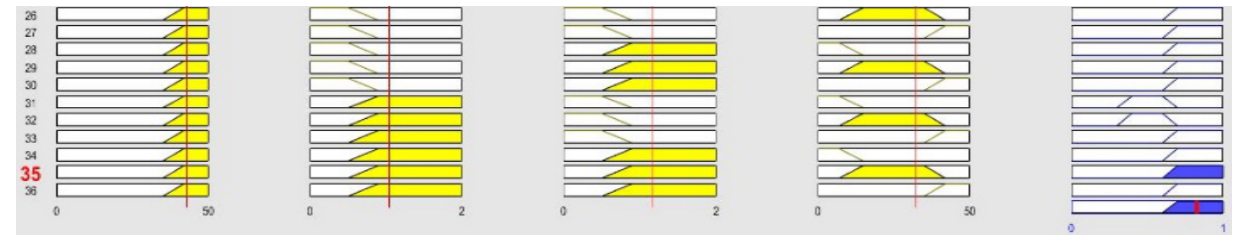
Figure 8. Lookup diagram of Proposed DA-AH-MFES Expert System for Acute Arthritis